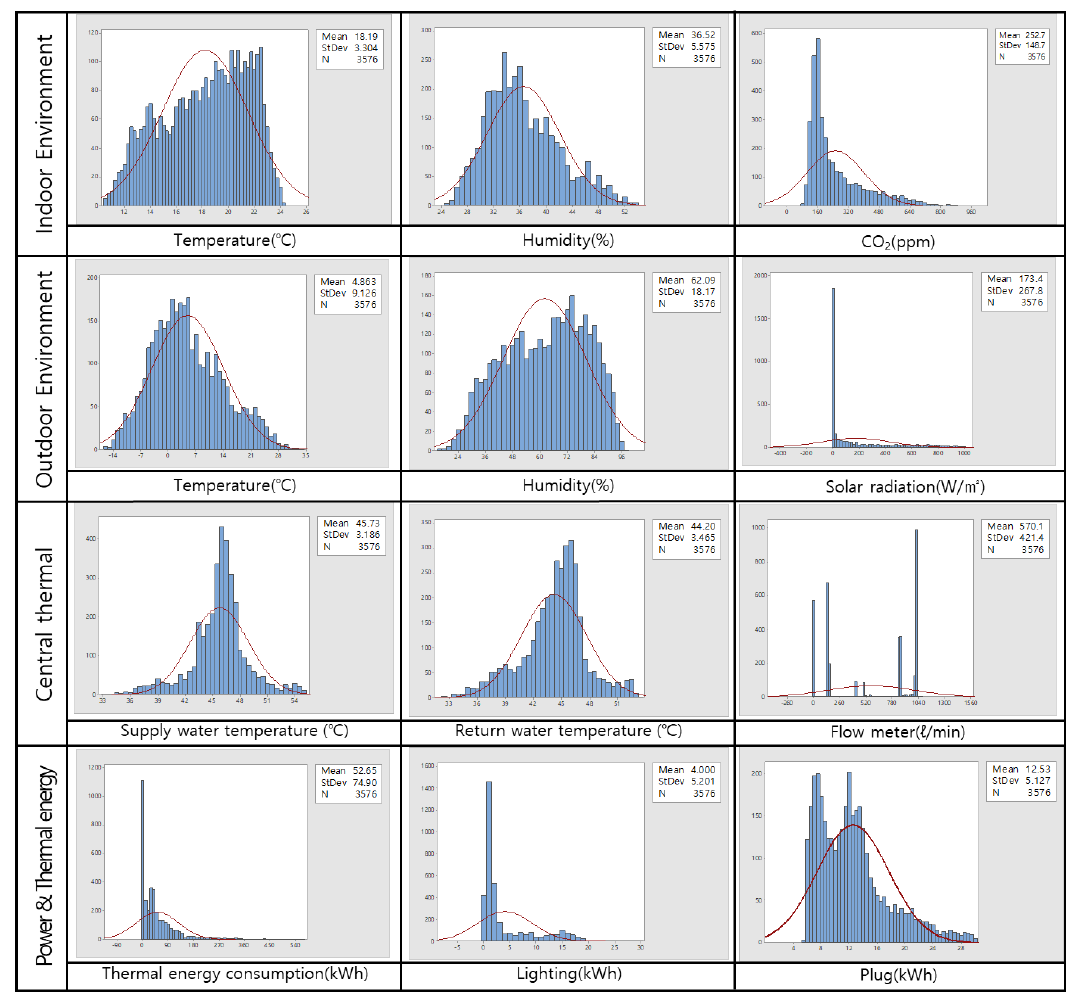
Figure 4. Distribution of measured data.